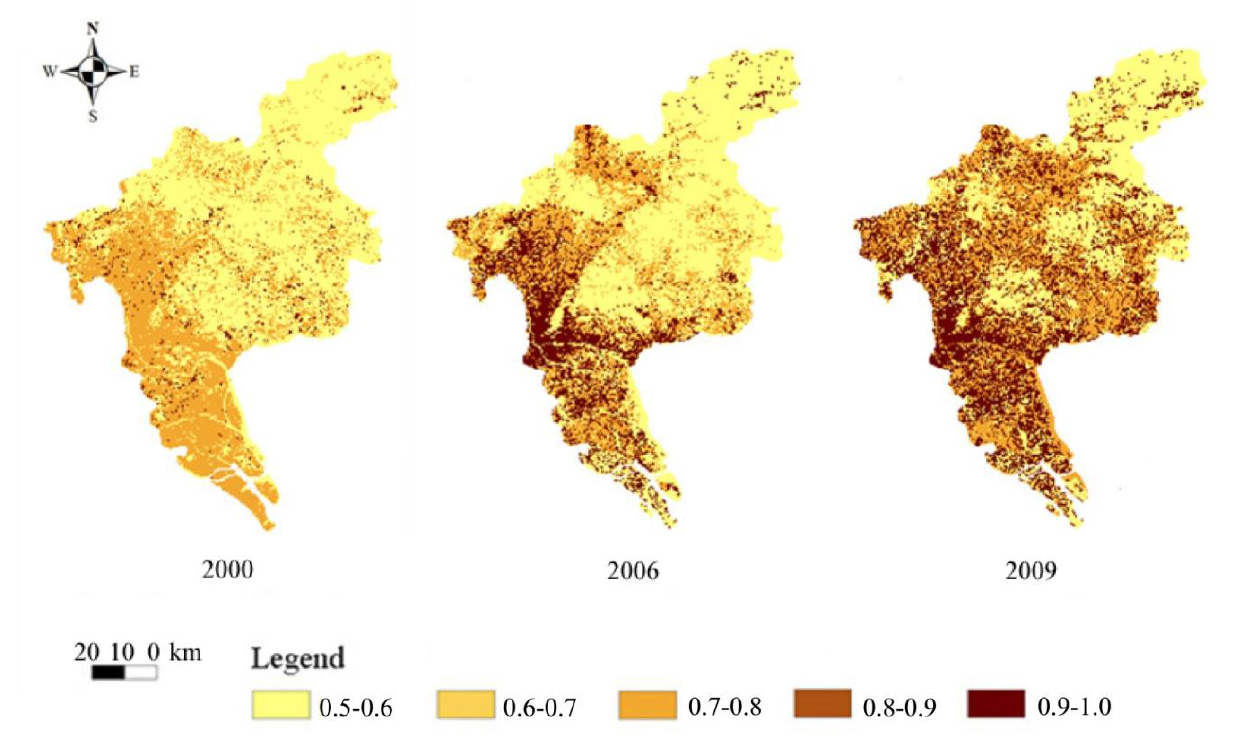
Figure 4. Spatial differentiation of unit supply index.